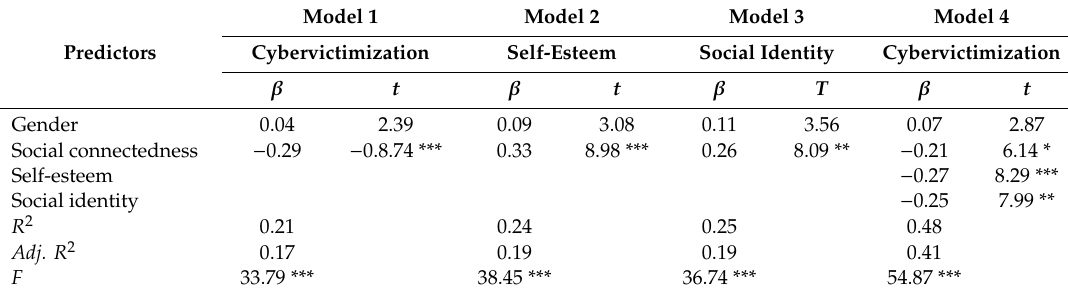
Table 3. Testing the mediation e ff ect of social connectivity on cybervictimization.